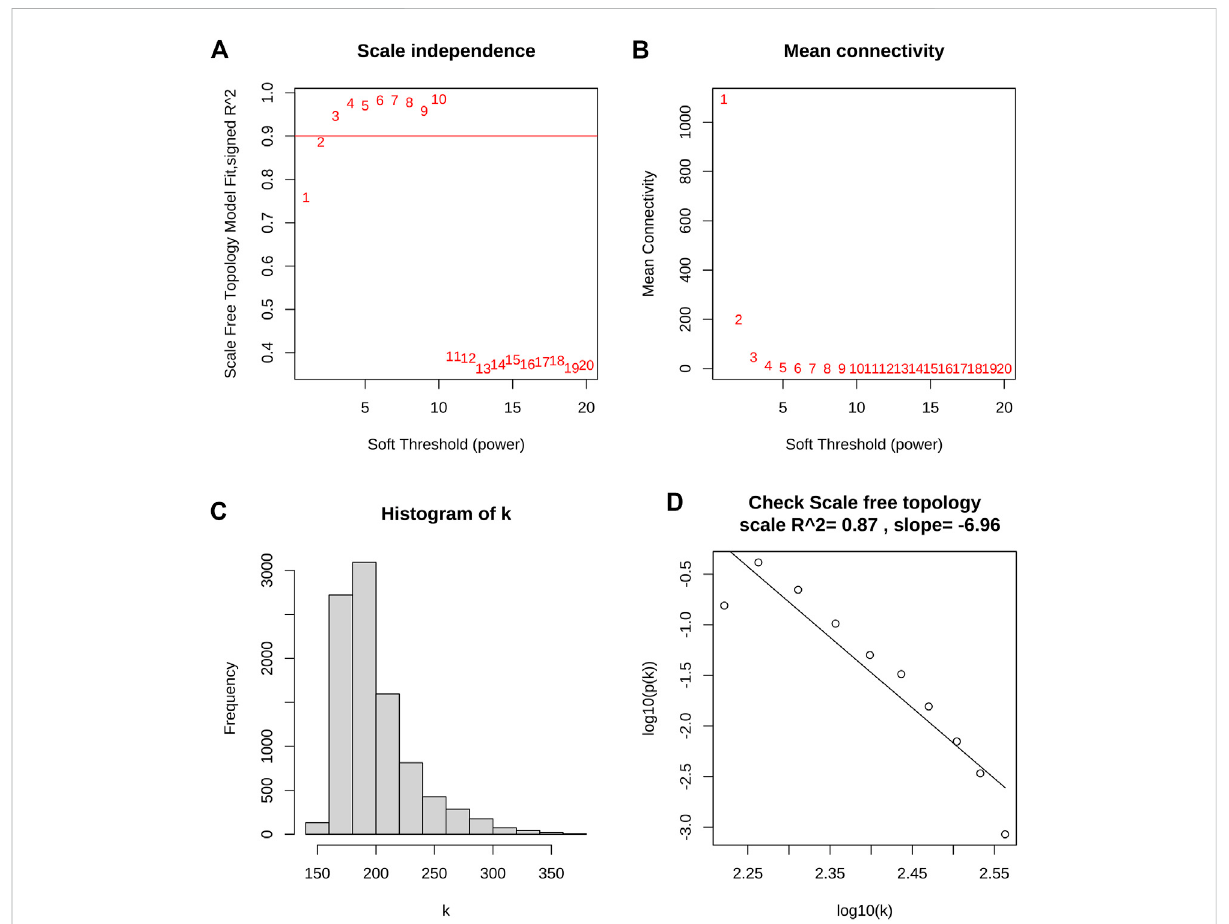
FIGURE 3 Determination of optimal soft threshold power for scale-free topology. (A) The scale-free topology fi t index ( R 2 ) for soft threshold power ( β ) from 1 to 20. (B) The mean connectivity (k) for β from 1 to 20. (C) Histogram of connectivity frequency. (D) The scale-free topology R 2 between log 10 (k) and log 10 (p(k)) when β =